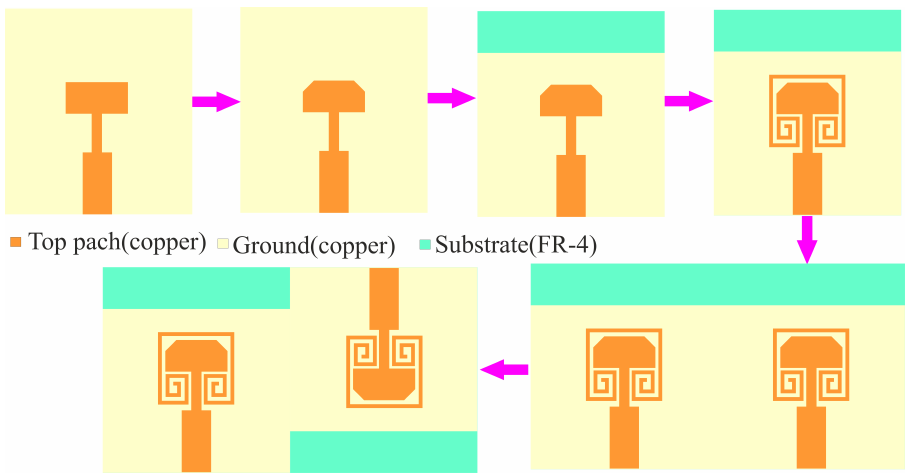
Figure 1. The design flow of the proposed